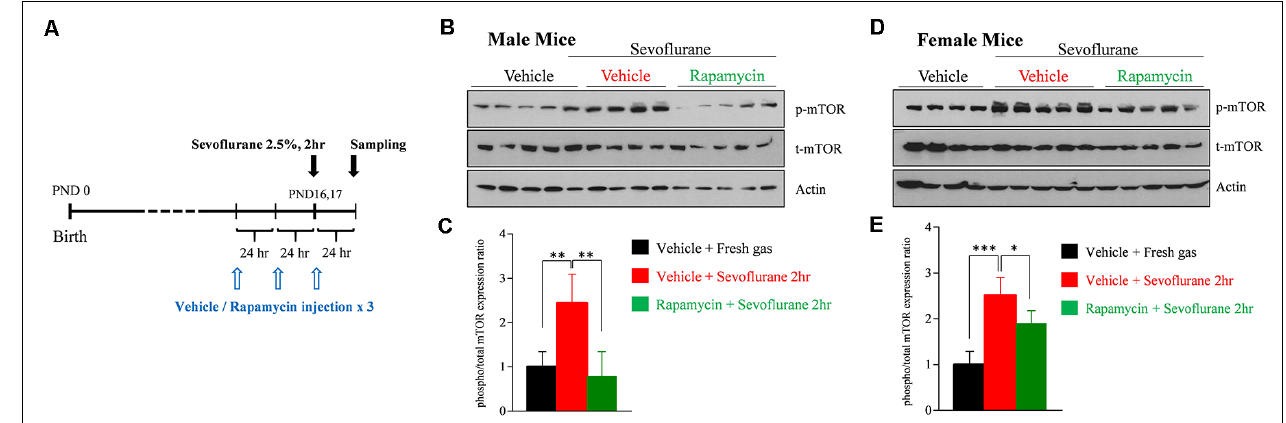
FIGURE 1 | Rapamycin prevents sevoflurane-induced activation of mammalian target of rapamycin (mTOR) signaling in male and female postnatal day (PND) 16/17 mice. (A) Time schedule for experiments. PND 14/15 mice were intraperitoneally injected with vehicle or rapamycin once daily for 3 days. On day 3 (PND 16/17), the mice were exposed to 2.5% sevoflurane anesthesia for 2 h. On day 4, mice were sacrificed and their whole brains were extracted. (B–E) Western blot of whole-brain samples obtained 24 h after sevoflurane exposure. (B,D) Western blotting with antibodies specific for phosphorylated and total mTOR and actin (loading control) in male and female mice. (C,E) Quantification of mean ± SD protein band intensity in panels ( B,D ; n = 4 or 5 per group; ∗ p < 0.05, ∗∗ p < 0.01, ∗∗∗ p <